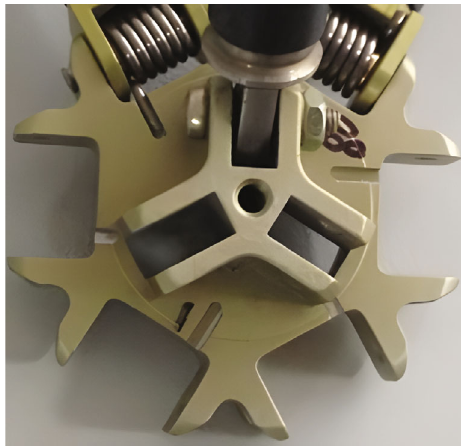
Figure 6: Connection between disk and